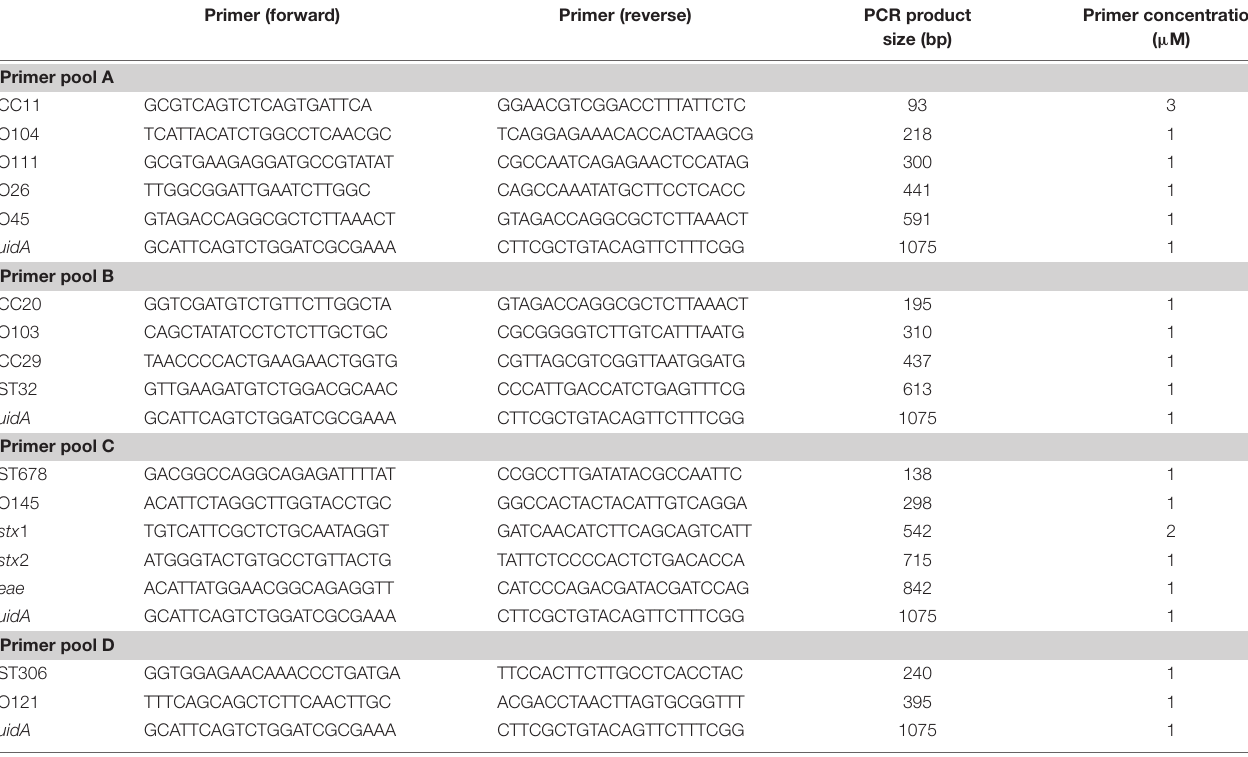
TABLE 1 | PCR primer sequences and concentrations used in this study. Primer (forward) Primer (reverse) PCR product